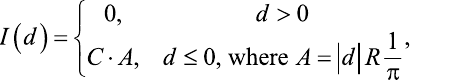
where ψ is the tip trajectory, and sq( τ , T ) is the square wave function with period T and duty cycle τ , ranging from zero to unity and with a duty cycle centred around zero time [43]. It is clear that τ , the duty cycle of the square wave function, corre- sponds to the effective interaction time between the tip and the sample. Upon introduction of sq( τ , T ), which has a well-defined Fourier transform, our indentation will automatically be zero whenever there is a positive tip–sample distance (see Figure